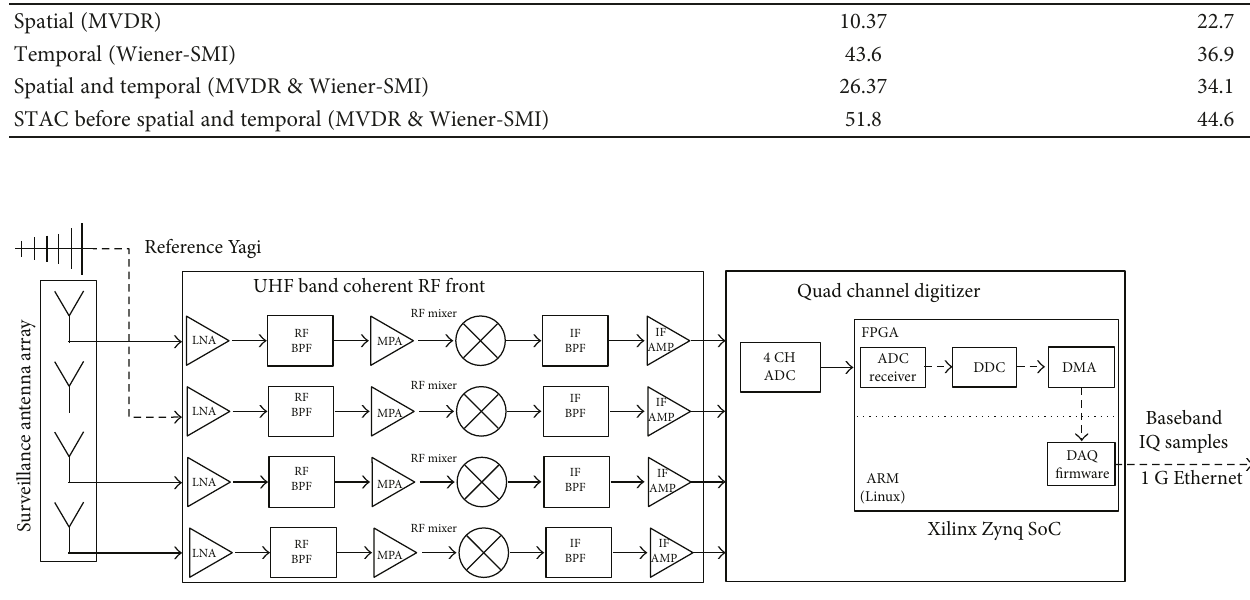
Figure 11: Block diagram of the demonstrator hardware and its antenna channel